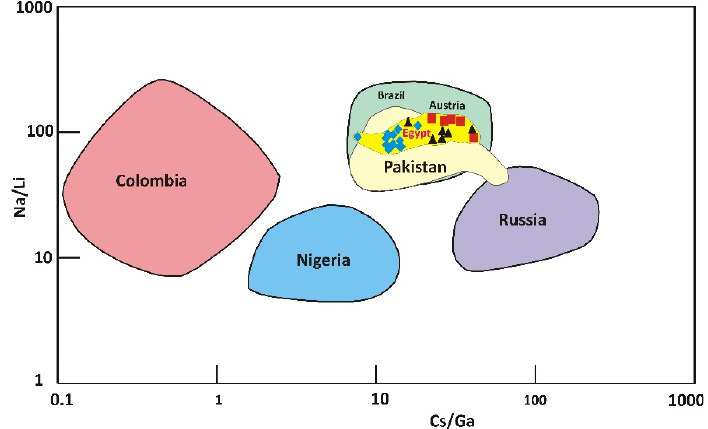
Figure 10. Na/Li vs. Cs/Ga binary discrimination diagram indicates the relationships between beryl from Wadi Nugrus, South Eastern Desert, Egypt, and different localities worldwide (Russia, Nigeria, Colombia, Santa Terezinha, Habachtal and Swat Valley) according to [76]. The diagram shows that the chemical ratios of Cs/Ga and Na/Li of emerald from Santa Terezinha de Goi á s (Brazil), Swat Valley (Pakistan), and Habachtal (Austria) fall in the same field. Symbols are the same as Figure 5: red square for bright-green rim (spots 1–5), black triangle for pale-green rim (spots 20–25) and blue lozenge for brown-green core (spots 6–19) of beryl